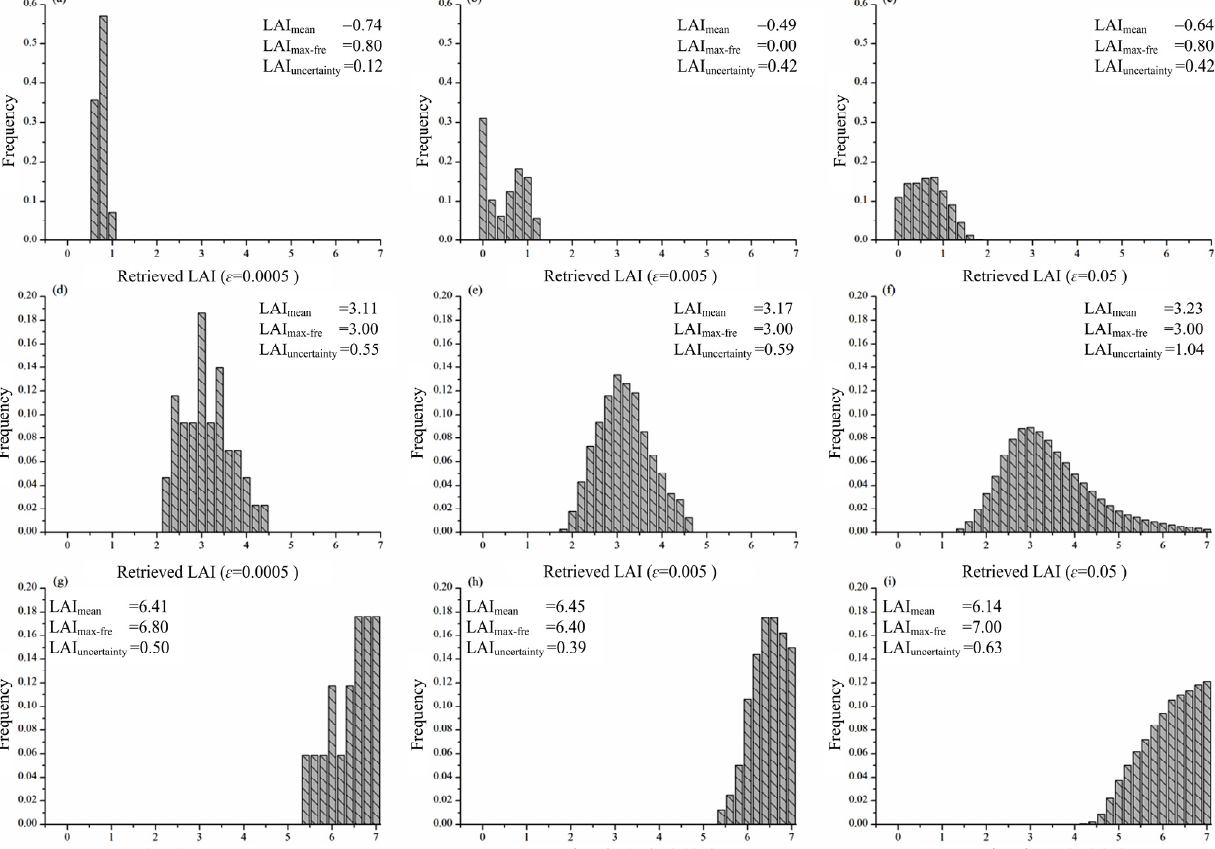
the 1:1 line, and the solid line is the least-squares regression line. Of 38 points, the residual sum of squares (RSS), coefficient of determination (R 2 ), and root-mean-square error (RMSE) values were 3.47, 0.68, and 0.31, respectively. Because the points were clustered at low LAI values (≤1.0), the